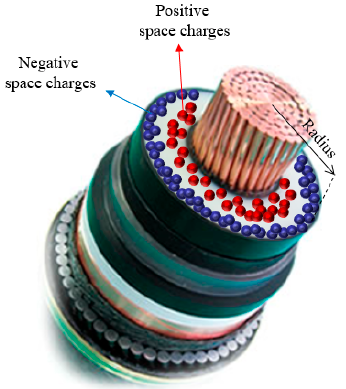
Figure 1. High voltage direct current (HVDC) cable with accumulated surface and space charges.